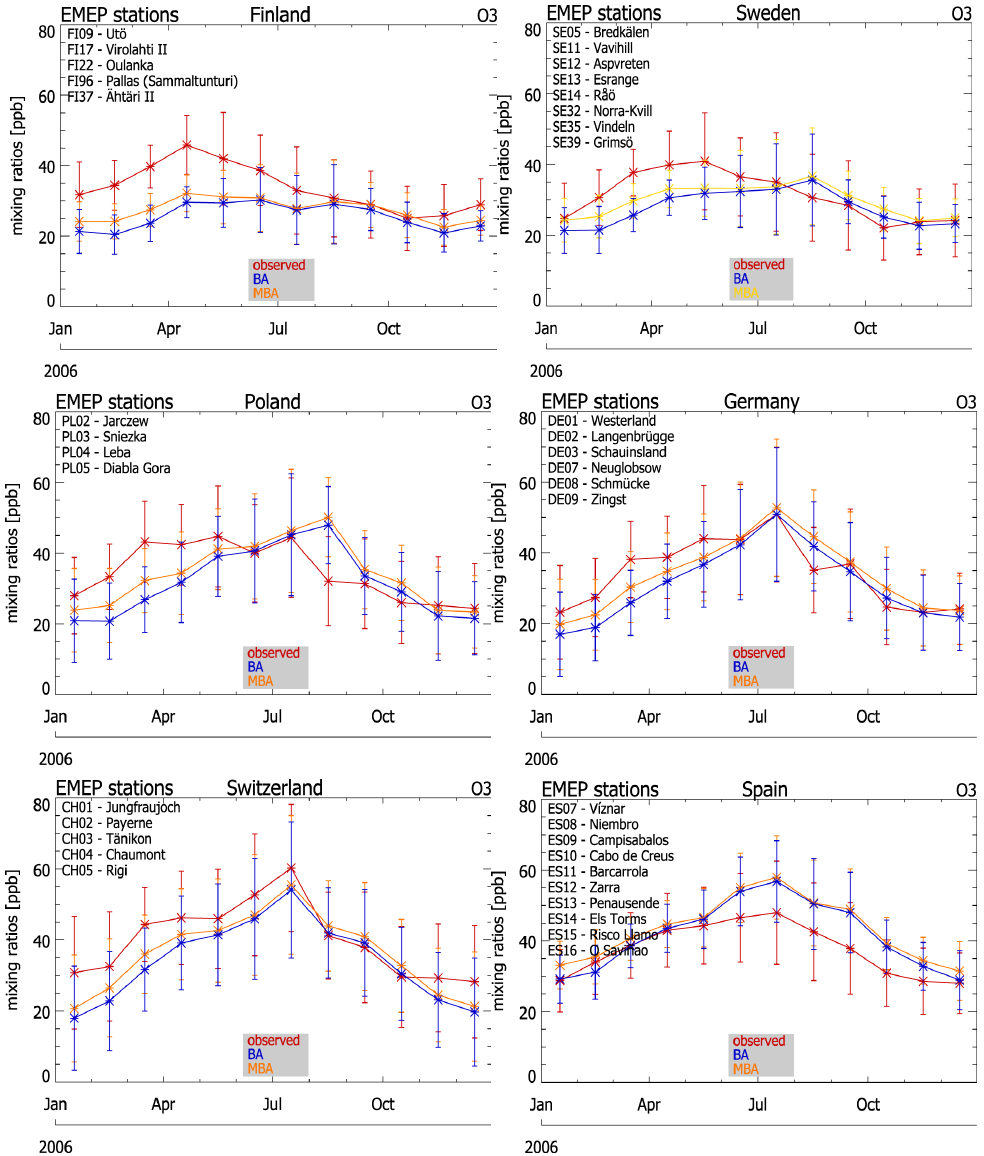
Fig. 7. Comparisons of the seasonal cycle of surface O 3 during 2006 with EMEP composites for selected countries in Europe. The error bars Figure 7 represent the 1- σ spread in the model mean values. The names of the EMEP stations used for each composite are shown top left, with the choice being constrained by data